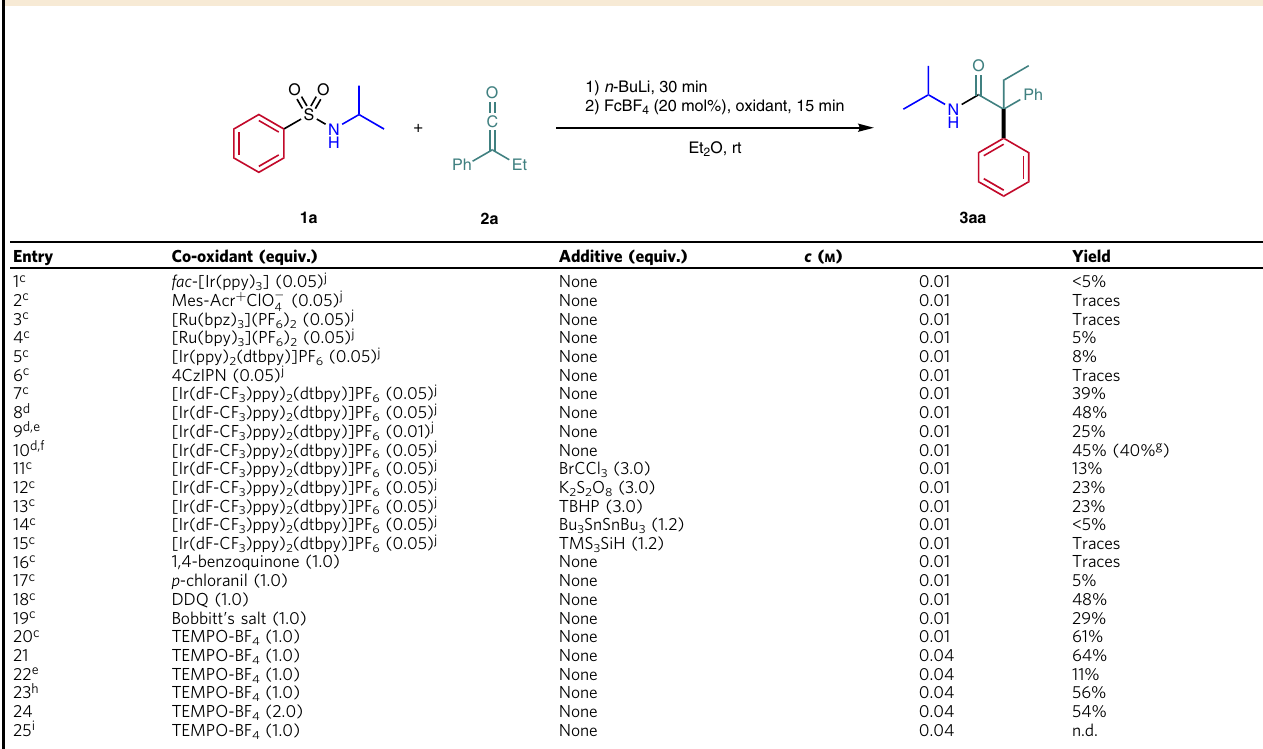
Table 2 Reaction optimization using catalytic amounts of ferrocenium tetra fl uoroborate a,b